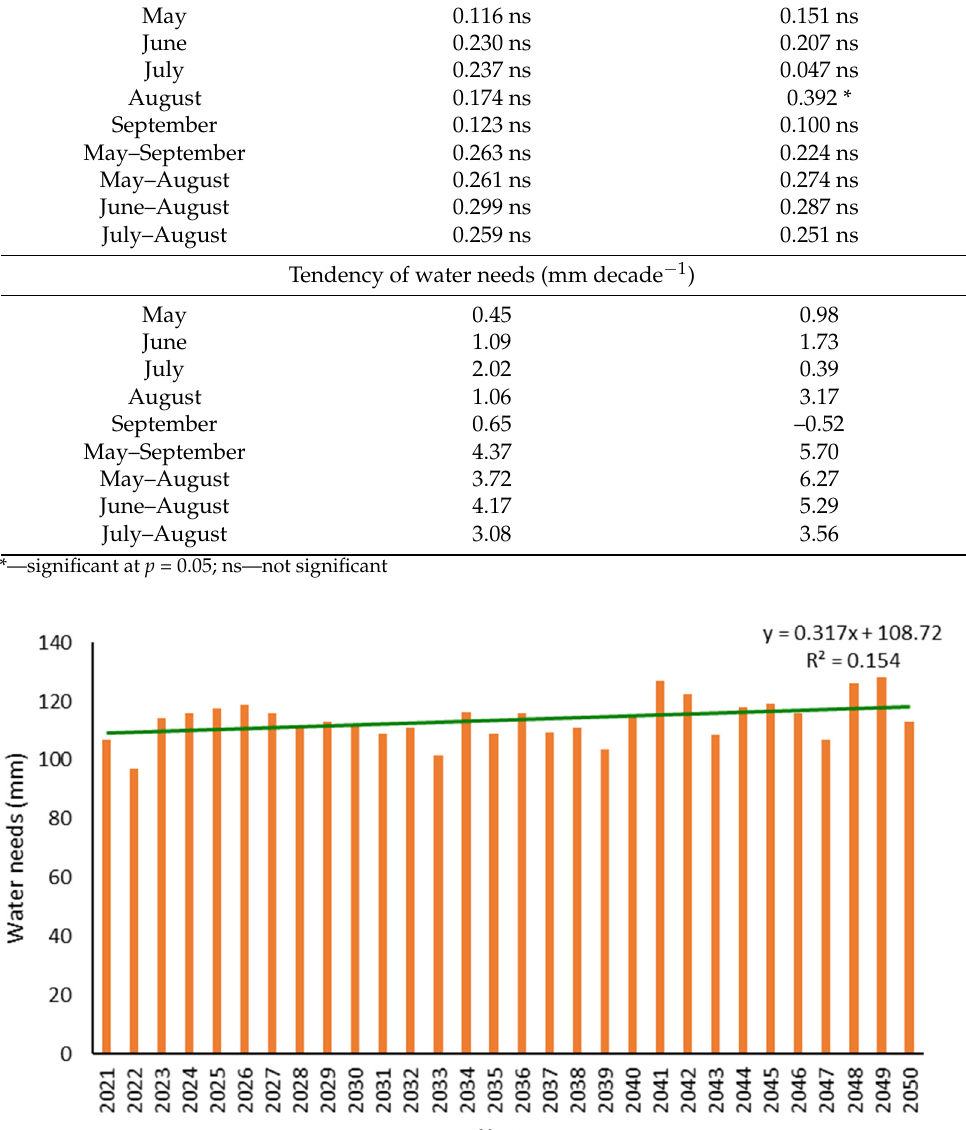
Figure 4. Daily water needs of grapevines during the growing season in the reference years (1981– 2010) and in the forecast years (2021–2050).